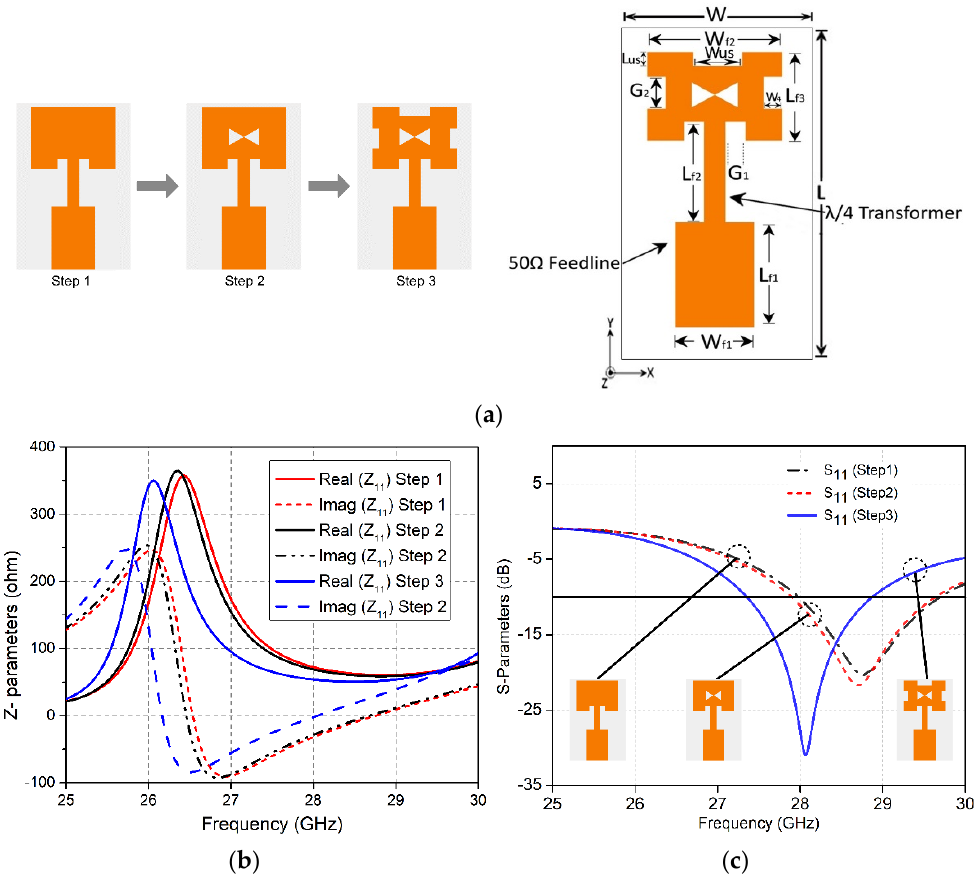
Figure 2. ( a ) The single antenna and its design procedure; ( b ) Z-parameter of the single antenna; ( c ) S-parameters of the single antenna.